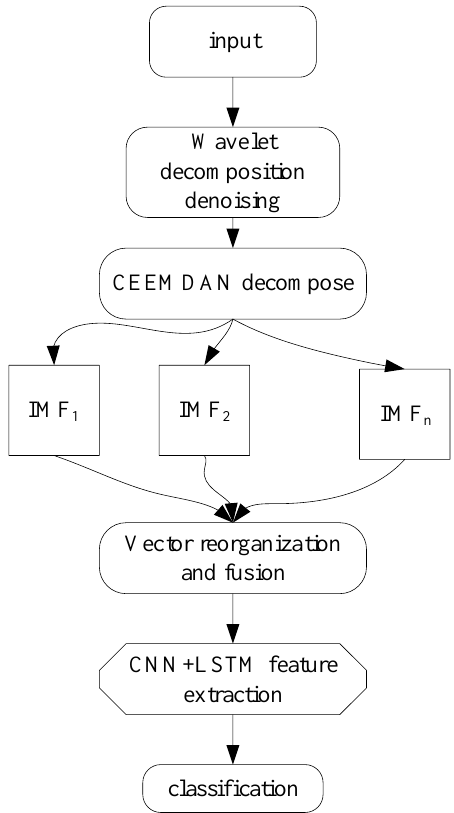
Figure 2. Fault diagnosis process of building frame structure.